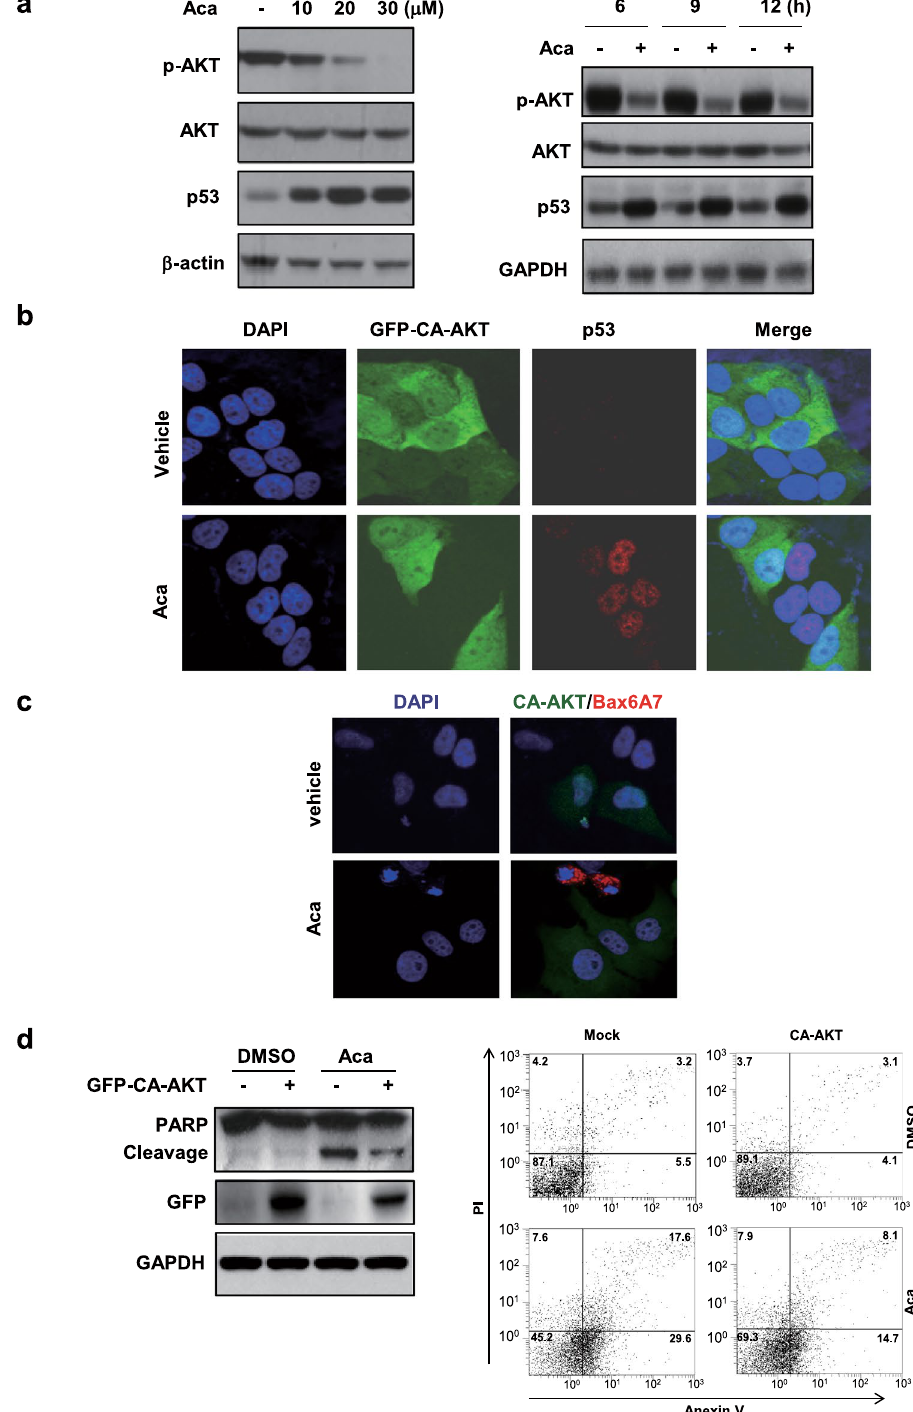
Figure 5. AKT is a potent inhibitor of p53. ( a ) HepG2 cells were treated with different concentrations of acacetin for 6 h or with 15 μ M acacetin for different time intervals. The inverse relationship between phosphorylated AKT and p53 was shown in the Western blotting. ( b ) HepG2 cells were transfected with constitutively active AKT (GFP-CA-AKT) and treated with 15 μ M acacetin for 12 h. The cells were then immunostained with anti-p53 antibody and co-stained with DAPI. ( c ) HepG2 and its GFP-CA-AKT-transfected cells were treated with 15 μ M acacetin for 12 h and then subjected to immuno-staining with conformation- specific Bax/6A7 antibody. The cells were co-stained with DAPI. ( d ) HepG2/CA-AKT and HepG/Mock stable cell lines were treated with 10 μ M acacetin for 24 h. The cells were then subjected to immunoblotting (left) or Flow cytometry assays (right). All blots were cropped to remove irrelevant or empty